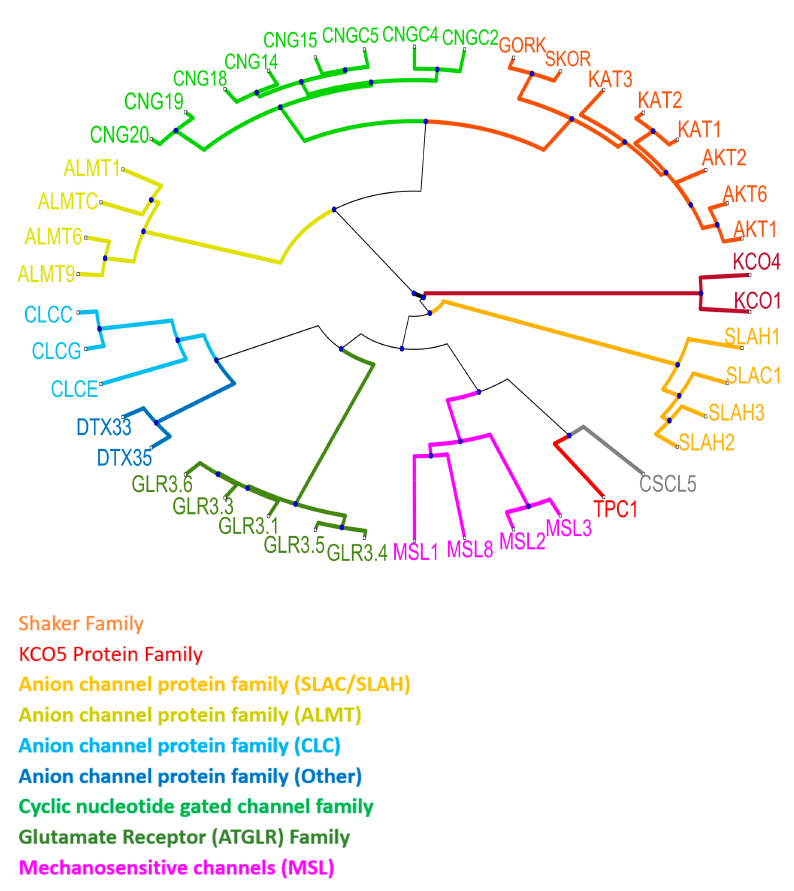
Figure 2. Phylogeny of plant ion channels. Representation of the phylogenetic tree of plant ion channels listed in Pantoja, 2020 [88], based on the analysis of protein homologs extracted from Uniprot.org. Progressive alignment and BLOSUM30 scoring method were used for multiple sequence alignment. The distance between the aligned sequences was calculated using Jukes-Cantor method. The phylogenetic tree was created by using the distance matrix. Unweighted pair group method average (UPGMA) was used to calculate group distance in the tree. Different colors represent different families of ion